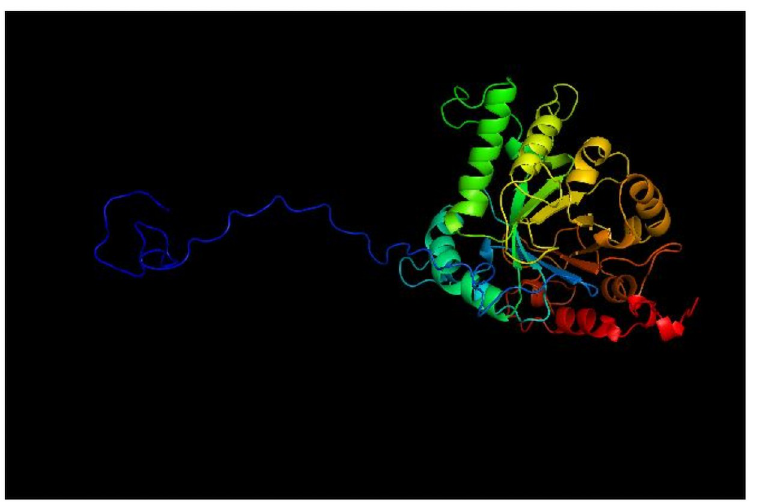
Fig 2. The tridimensional model predicts by Droppa-Almeida, Franceschi, and Padilha (2018) [17]. This model was used in this work to verify immunodominant epitope localization with Rasmol software.